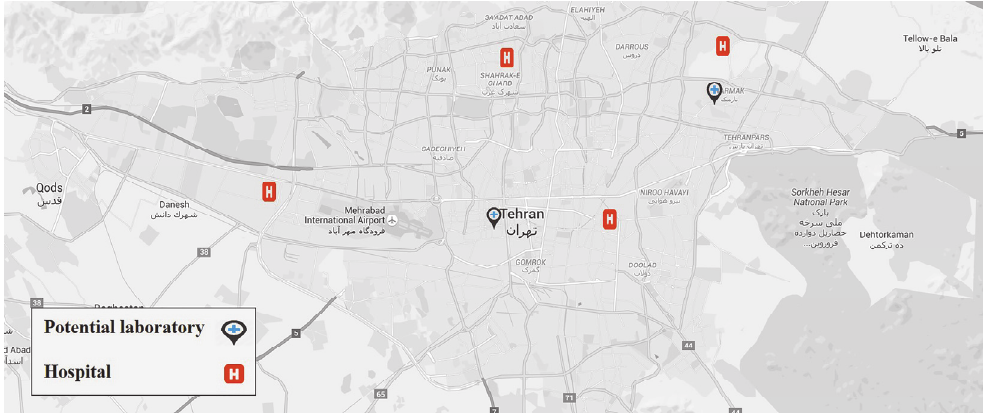
Fig. 3. Districts of Tehran and potential sites of processing